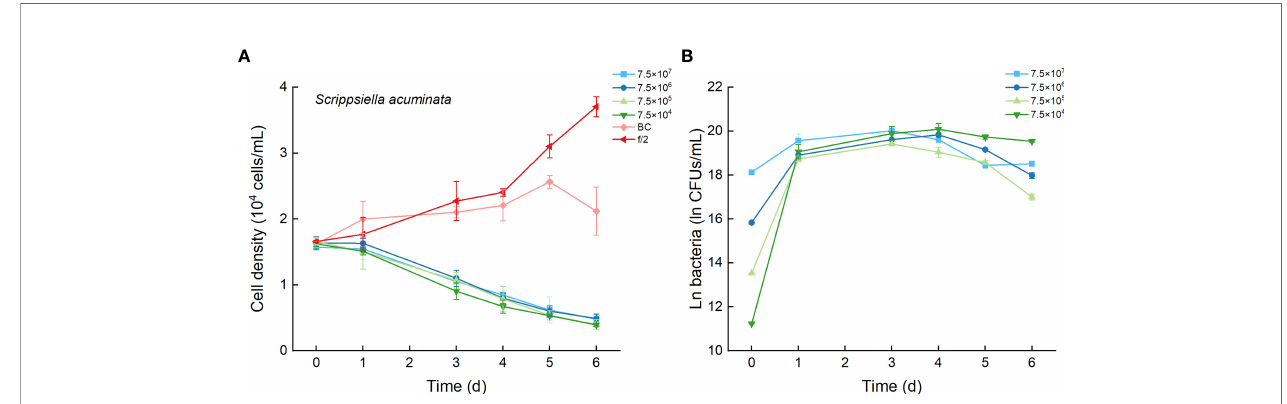
FIGURE 7 | The growth of Scrippsiella acuminata in the co-cultures with different concentrations of bacterial strain Lf7 (7.5×10 4 -7.5×10 7 CFUs/mL). (A) Growth curves of S. acuminata in co-cultures with Lf7, (B) Lf7 concentration in the algal cultures.